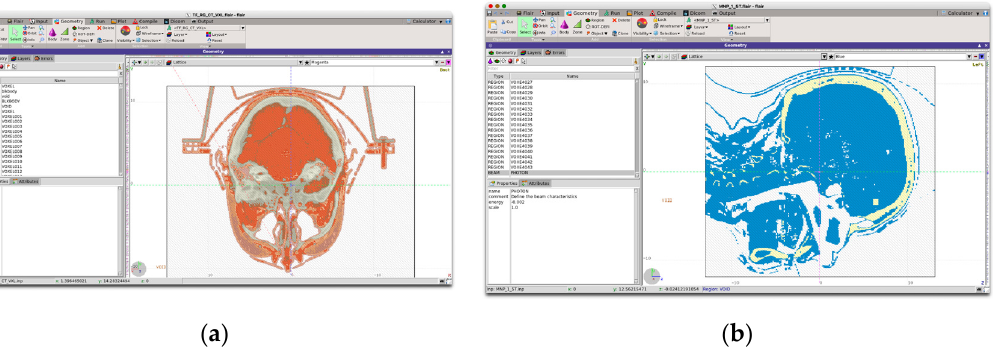
Figure 11. FLAIR simulation interface showing head–neck CT geometry on different planes ( a ) and the irradiation setup depicting the incident X-ray beam along the − z direction and the FeNP-infused (light-colored in frontal skull cortex) target volume ( b